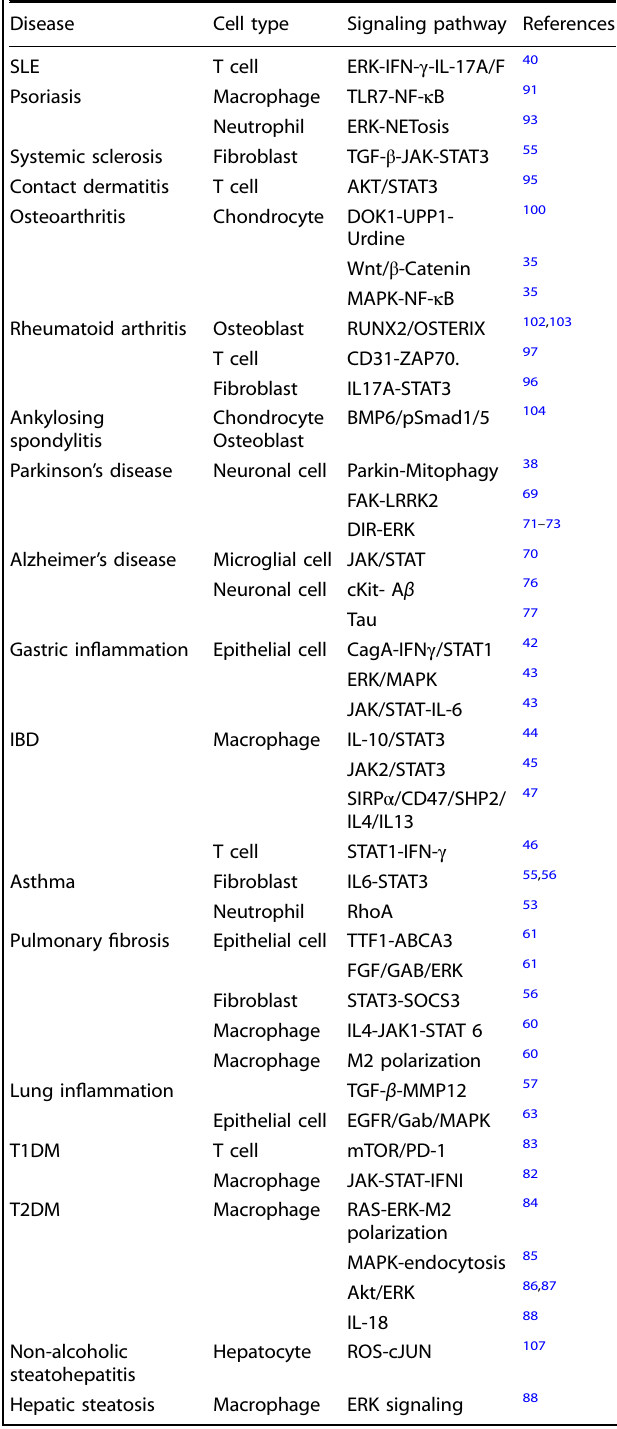
Table 2. The regulated signaling pathways of SHP2 involved in Disease